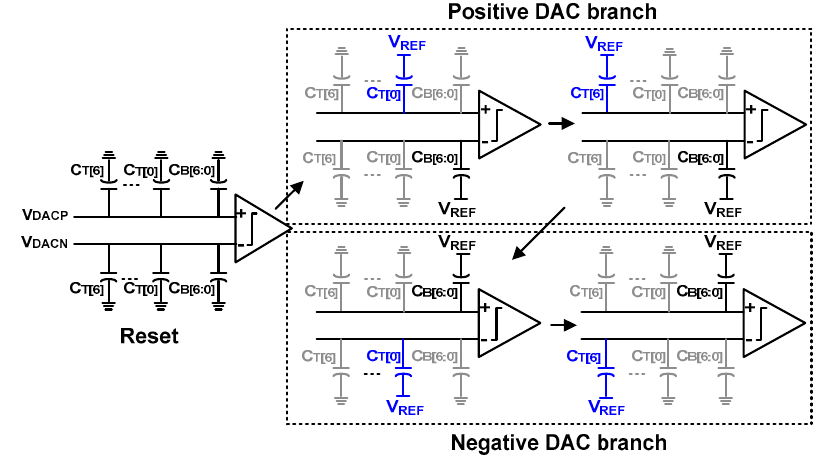
Figure 9. Sequence of the proposed digital-to-analog converter (DAC) mismatch calibration.